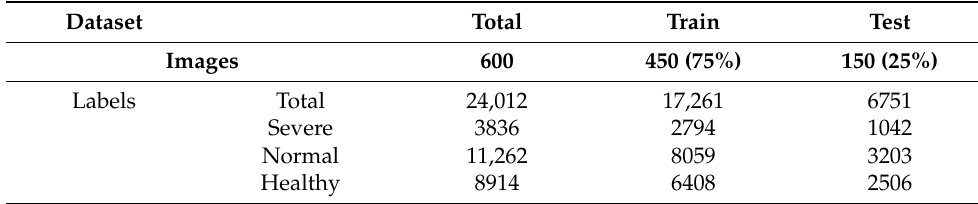
Table 1. Description of the dataset.